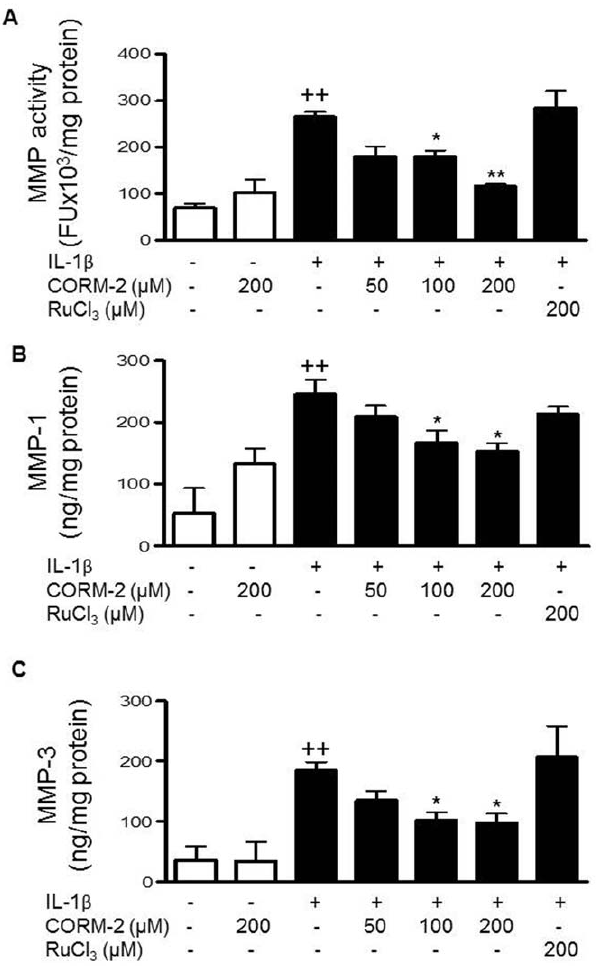
Figure 5. Effect of CORM-2 on MMP activity and MMP levels released into the culture medium in OA synoviocytes. (A) MMP activity, (B) MMP-1 protein, (C) MMP-3 protein levels in the culture medium. Cells were stimulated with IL-1 b (10 ng/ml) for 24 h in the presence or absence of CORM-2 (50, 100, 200 m M) or RuCl 3 (200 m M). MMP activity was analyzed by fluorometric procedures in cell supernatants (A) and protein levels were determined by ELISA in cell supernatants (B–C), Data are expressed as mean 6 S.E.M. Duplicate samples from 6 patients were used. ++ P , 0.01 with respect to nonstimulated cells. * P , 0.05 with respect to IL-1 b .